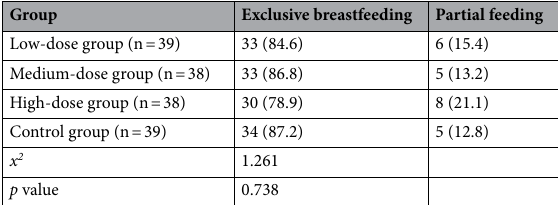
Table 6. The rate of exclusive breastfeeding for 3 months after birth [n